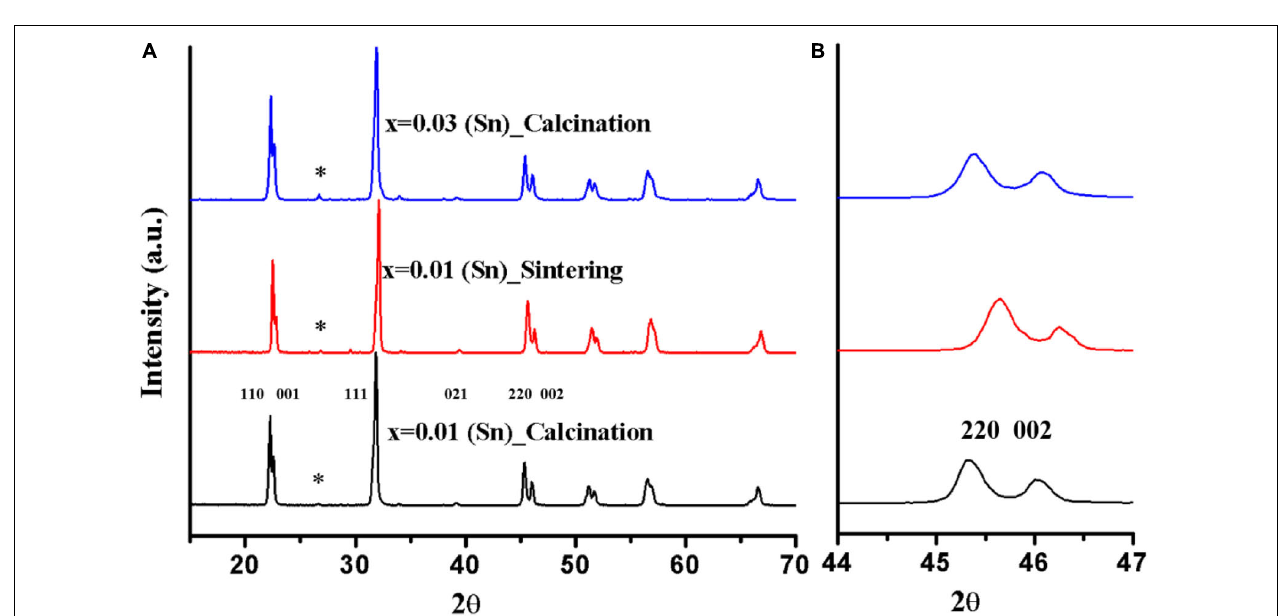
FIGURE 2 | (A) XRD patterns of Sn-doped KNN-50/50, (B) zoomed peak at 2 θ ∼ 45–46.